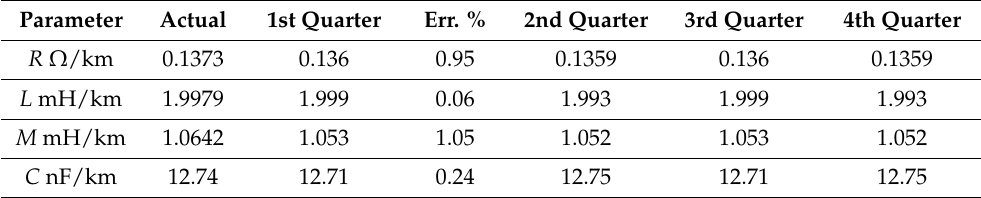
Table 2. Actual and estimated parameters using four quarters of the measured signals.